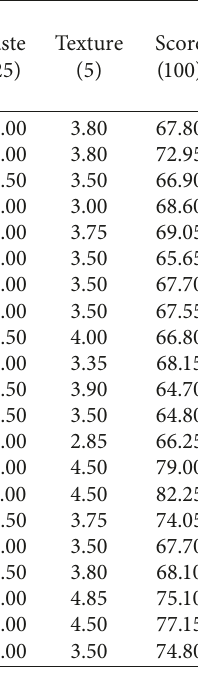
Table 1: The sensory evaluation of sorghum